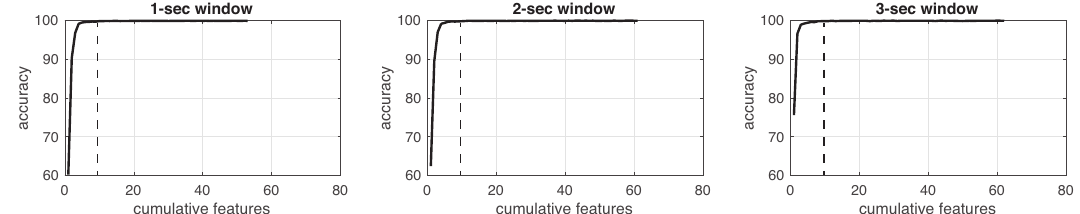
Figure 13. Accuracy performance on training using cumulative features for Experiment 6 : IR + CAM. From left to right, it presents the performance using: 1-second length windowing, 2-second length windowing and 3-second length windowing. The dash line reports the number of cumulative features employed for the next steps.